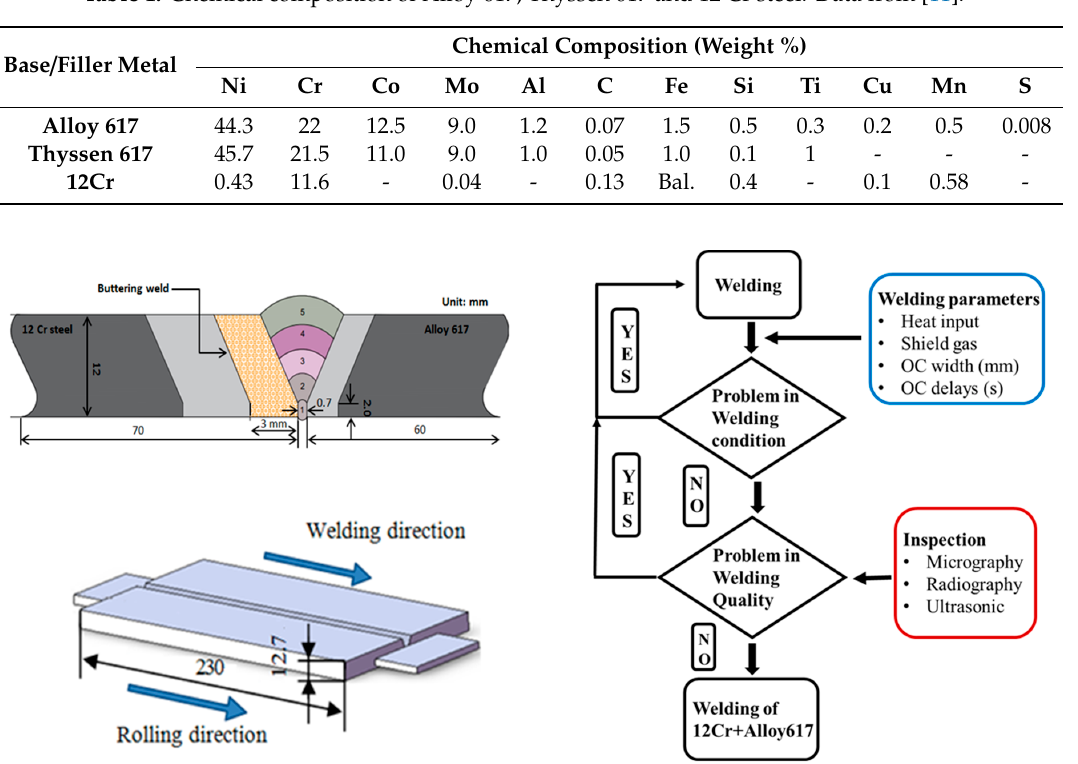
Figure 1. Buttering welding of Alloy 617 and 12Cr. Table 1. Chemical composition of Alloy 617, Thyssen 617 and 12 Cr steel. Data from [11].